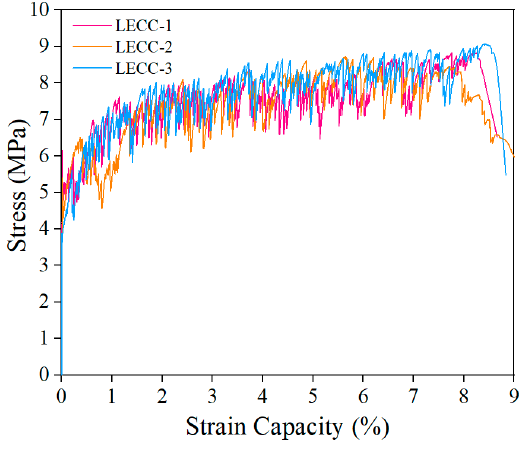
Figure 4. Stress–strain curve of the LECC.